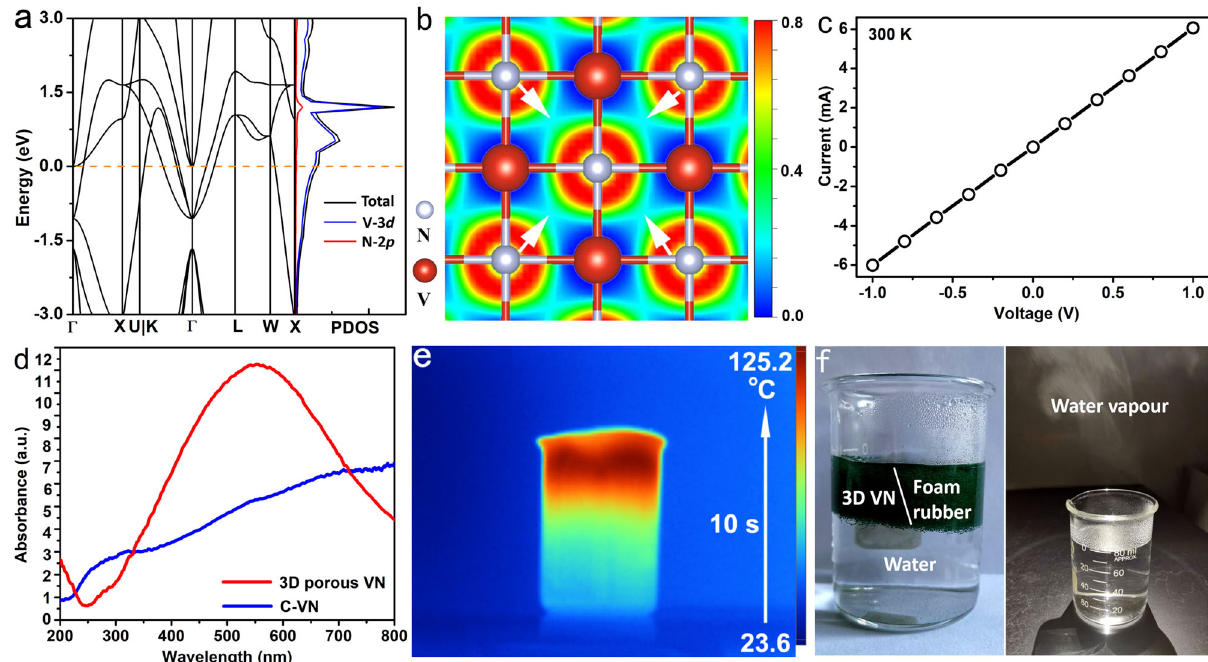
Fig. 6 SPR and photothermal effects of the 3D porous VN. a , b DOS and EIF of VN. c I – V curves of the 3D porous VN at 300 K. d UV – Vis absorption of the 3D porous VN. e Photothermal effect of the 3D porous VN. f Photothermal experimental device (left); no VN particles remain after removing the foam rubber